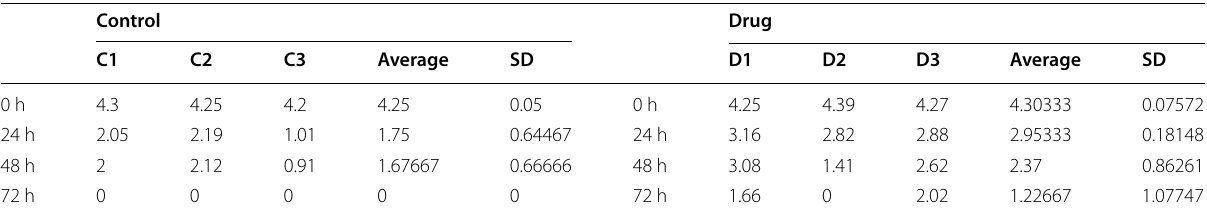
Table 1 Wound width in control and apricot oil extract group in different groups Control